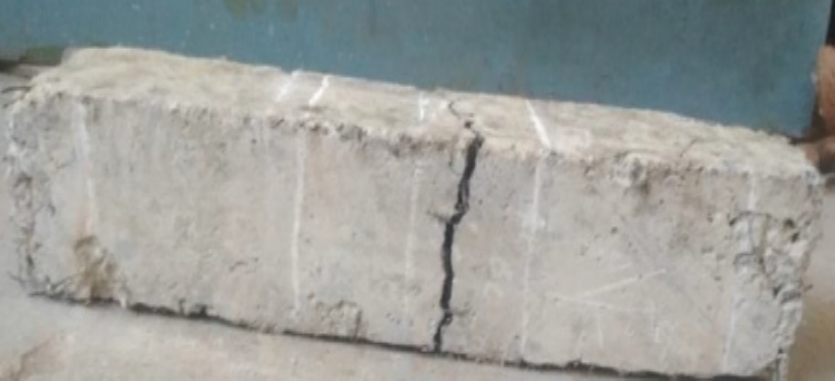
Figure 13. Failure of 1.5% Basalt Fiber Reinforced Concrete [50] with permission of Elsevier.